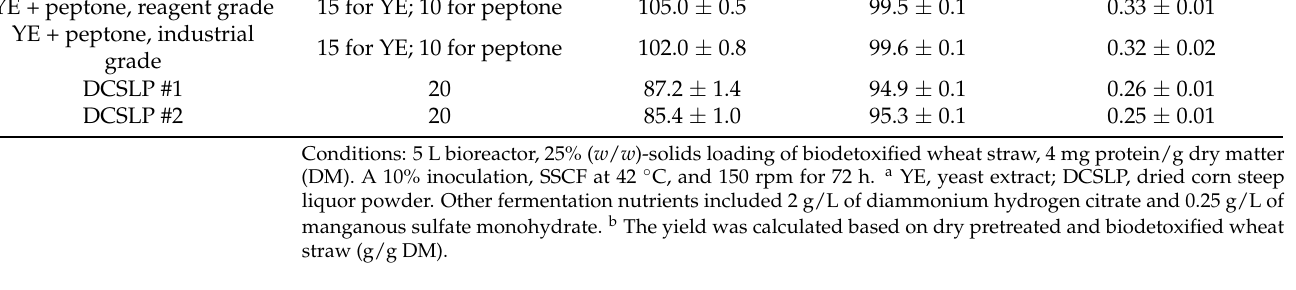
Table 2. Characterizations of the common complex nutrients used for lactic acid fermentation.